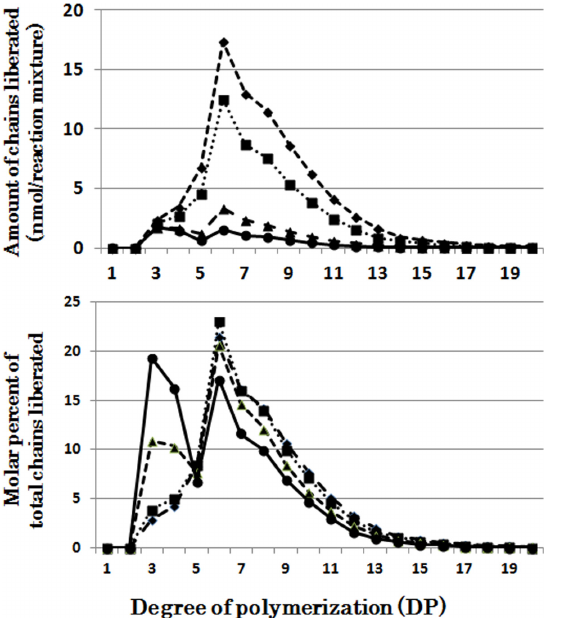
Fig 1. Chain-length preference of rice isoamylase1 (OsISA1) in debranching phytoglycogen. Upper panel shows the amount of chains liberated after enzymatic reaction with OsISA1 and phytoglycogen for 5 ( ● ), 10 ( ▲ ), 30 ( ■ ), and 60 ( ♦ ) min, respectively. Lower panel shows the molar percentage of each liberated chain to the total liberated